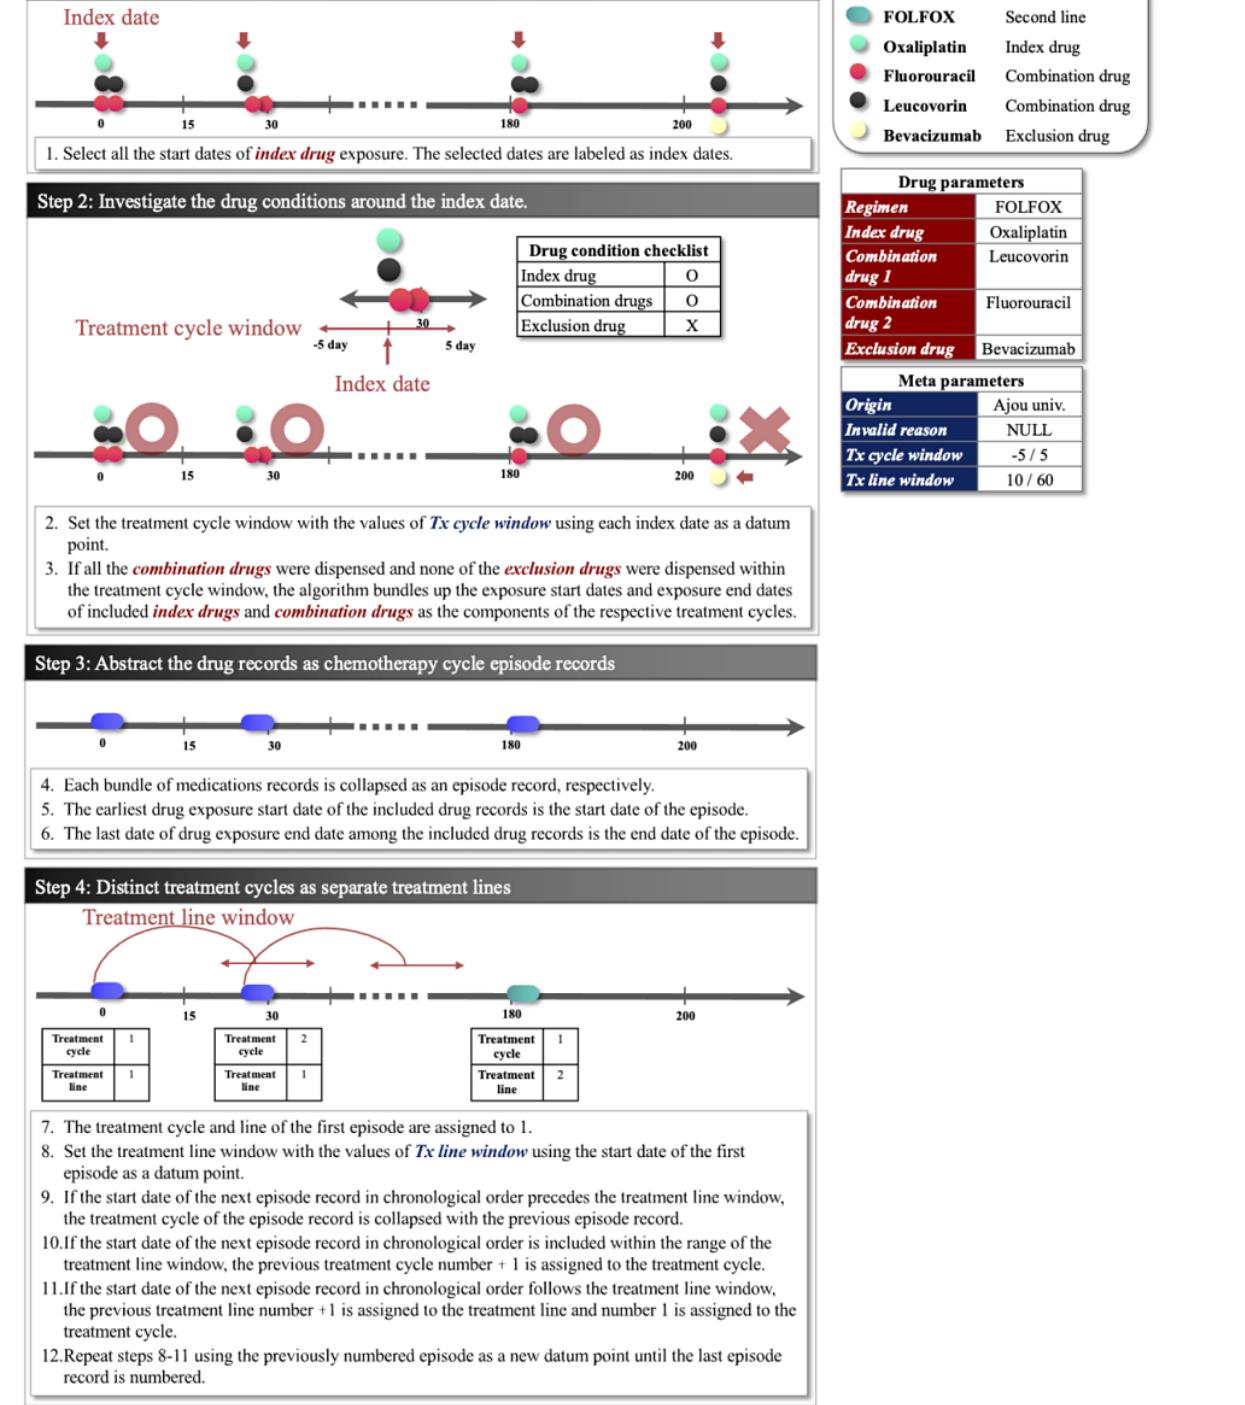
Figure 3. Definition of chemotherapy regimen episode extraction algorithm. FOLFIRI: fluorouracil, leucovorin, and irinotecan; FOLFOX: fluorouracil, leucovorin, and oxaliplatin; HDAC: Hierarchical Description for Administration of Chemotherapy.